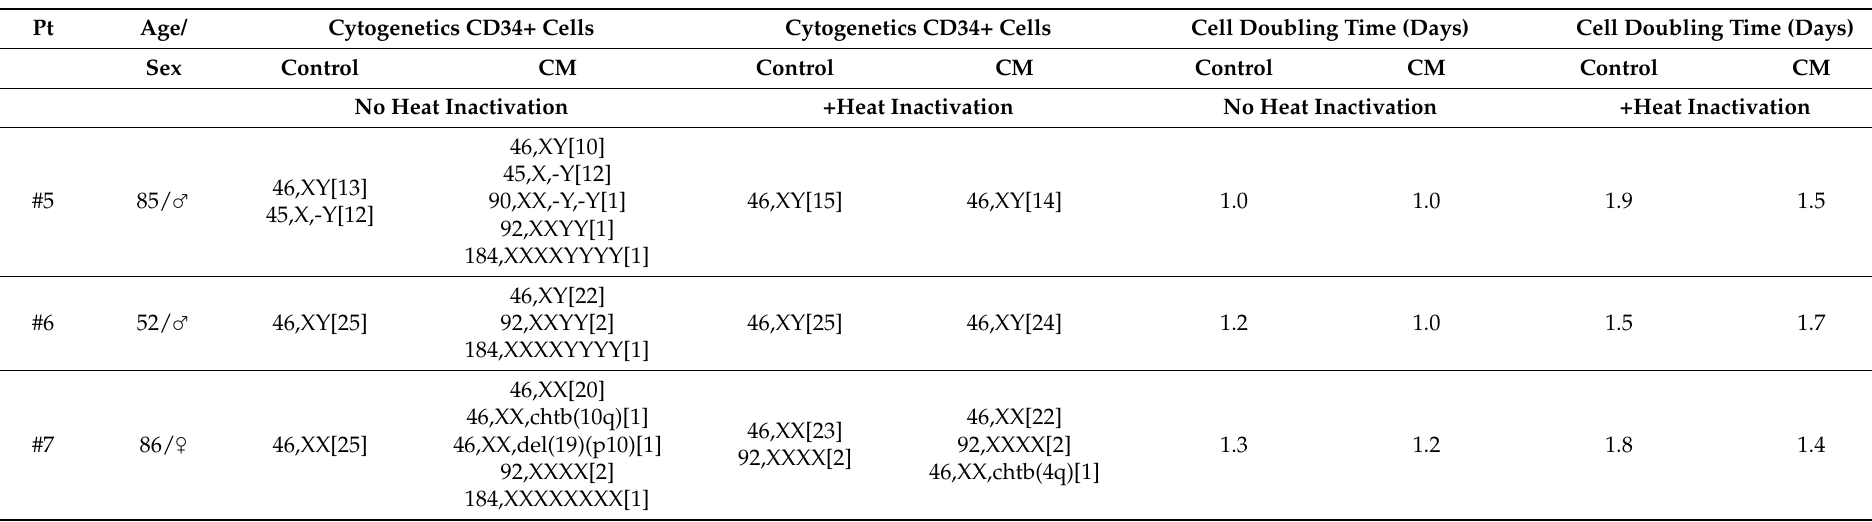
Table 2. Cytogenetics and cell doubling time in CD34+ cells grown for 3 days in heat-inactivated unfractionated medium conditioned by 2 Gy irradiated mesenchymal stromal cells. CM, conditioned medium; Pt, patient; [number] = number of